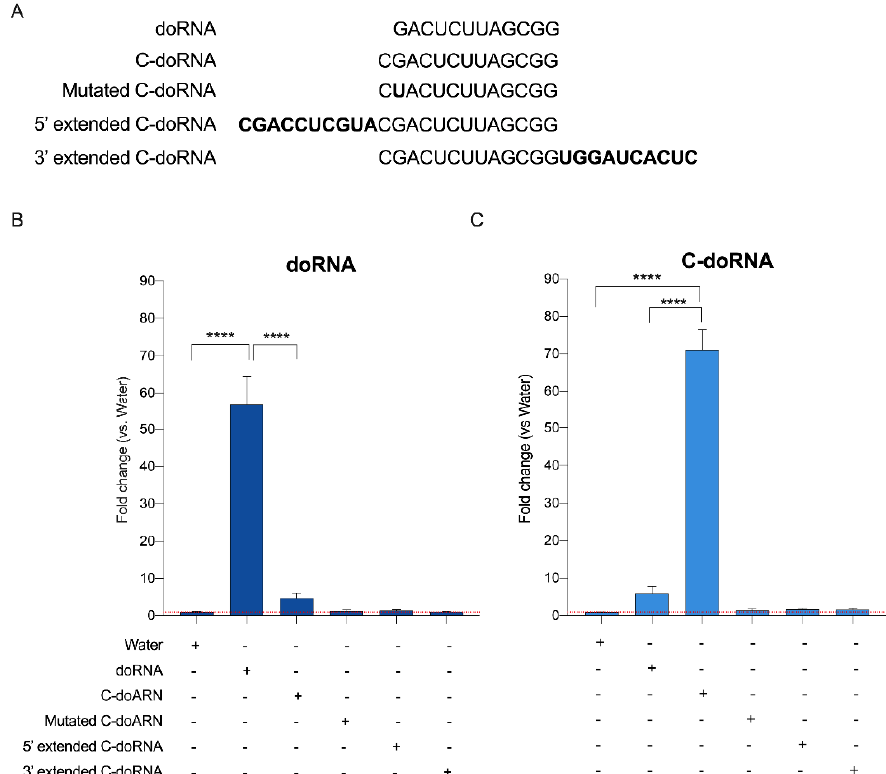
Figure 5. Splinted 5 (cid:48) ligation RT-qPCR may discriminate between doRNA, C-doRNA and precursor sequences. ( A ) Synthetic oligonucleotide sequences used to test the specificity of our splinted 5 (cid:48) ligation RT-qPCR method. Mutated C-doRNA was obtained by substituting G2 to U2 near the 5 (cid:48) end. The 5 (cid:48) and 3 (cid:48) extended C-doRNAs were 10-nt extensions of C-doRNA in the 5 (cid:48) or 3 (cid:48) direction of the 5.8S rRNA precursor sequence, respectively. ( B , C ) Total RNA (300 ng) from N2a cells was used, followed by addition of 6.02 × 10 9 copies of the indicated synthetic oligonucleotides (or water, as control) in a final volume of 2 µ L. The qPCR data were normalized on U6 RNA levels, and the fold change was calculated by monitoring doRNA ( B ) or C-doRNA ( C ) versus the control sample (mean ± SEM; n = 4 independent experiments). The symbol (+) denotes the presence, and ( − ) the absence of the indicated component. The horizontal dotted red line indicates a fold change of 1 (no change). **** p < 0.0001 (one-way ANOVA with Holm–Sidak’s post hoc